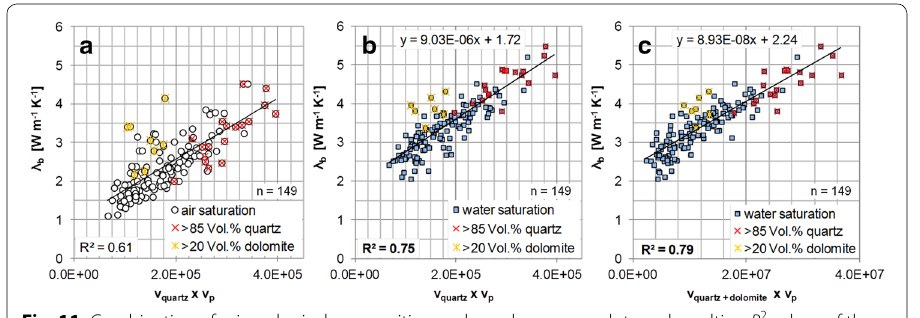
Fig. 11 Combination of mineralogical composition and v p values: cross-plots and resulting R 2 values of the product of total quartz volume fraction ( v quartz ) and v p versus a bulk thermal conductivity ( λ b ) of air-saturated sandstones and b bulk thermal conductivity ( λ b ) of water-saturated sandstones. c The product of the total quartz dolomite volume fraction ( v quartz ) and v p plotted versus λ b achieves the best correlation + + dolomite of R 2 0.79 in the case of water-saturated sandstones. λ b and v p are measured parallel to bedding. Samples = characterized by > 85 vol.% total quartz and samples with > 20 vol.% dolomite are